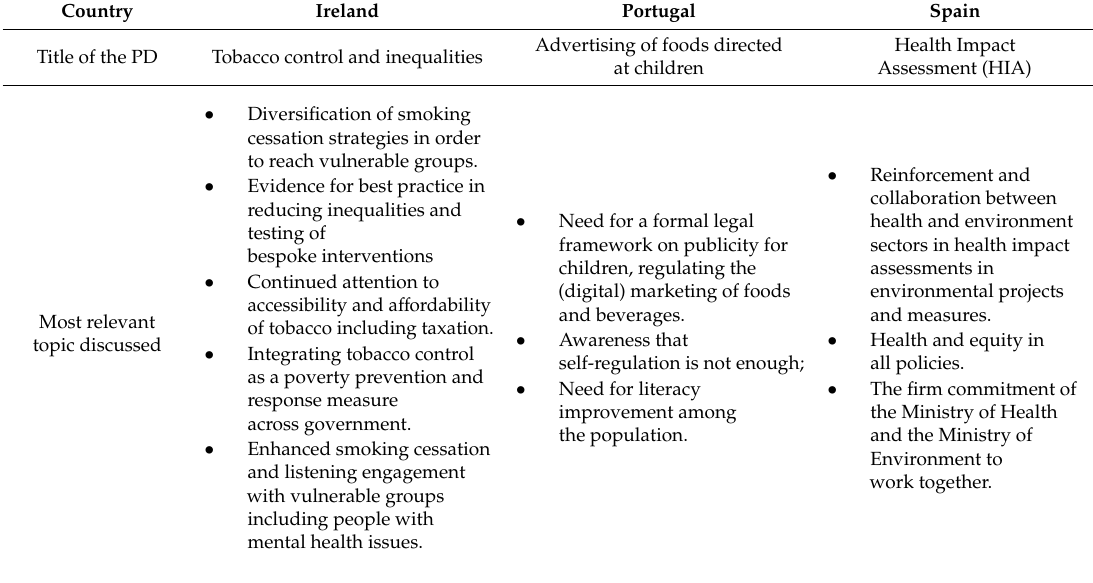
Table 2. Summary of the main conclusions of the national policy dialogs in Ireland, Portugal and Spain.